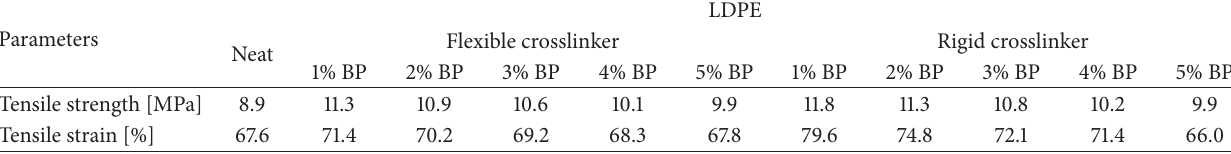
Table 4: The mechanical properties for the LDPE/BP injected